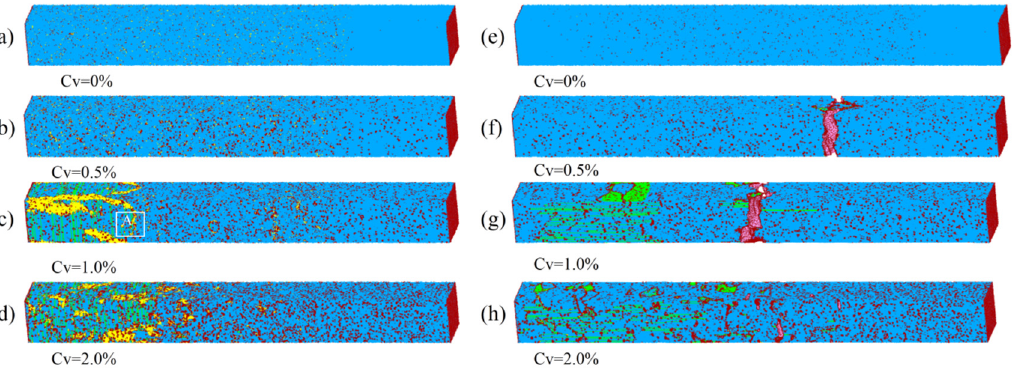
Figure 4. Atomic configurations for single-crystal magnesium with C v = 0%, 0.5%, 1.0%, and 2.0% during shock compression ( a – d ) at 20 ps and during tension ( e – h ) at 65 ps impacted along the [10-10] direction under V p = 0.5 km/s.